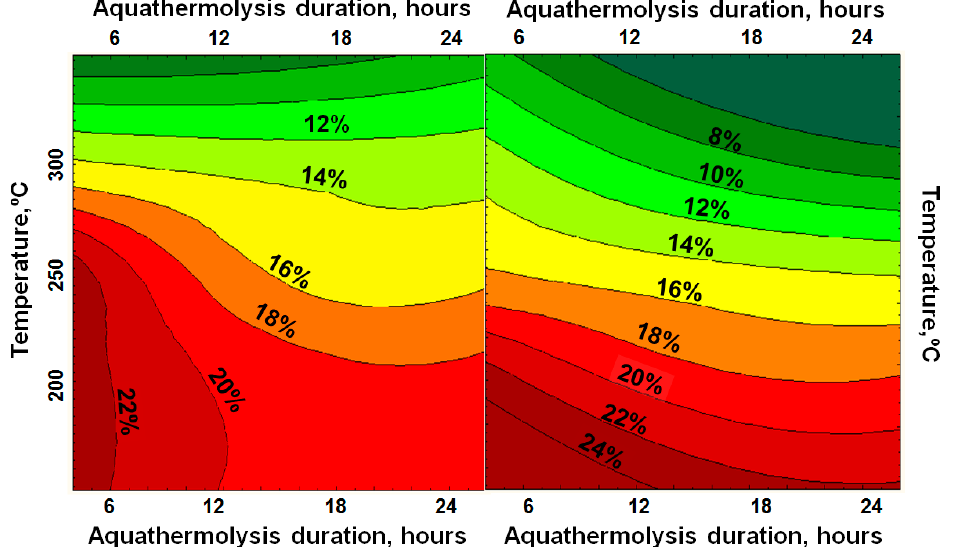
Figure 4. The influence of various reaction conditions (aquathermolysis duration and temperature of experiments) on the content of asphaltenes (wt%) in the presence ( right ) and absence ( left ) of a nickel-based catalyst.